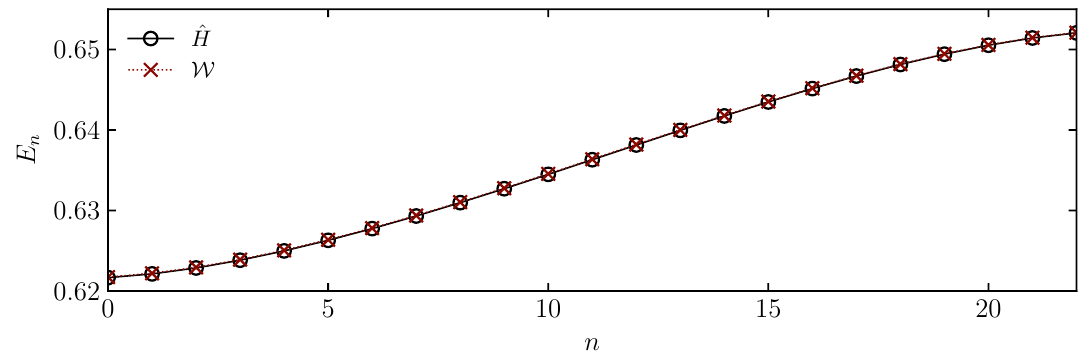
Figure 7: Quantum and classical dispersion relations for a particle in a periodic potential (77). The two lines representing the quantum and classical spectra are visually indistinguishable. The parameters are V and β =